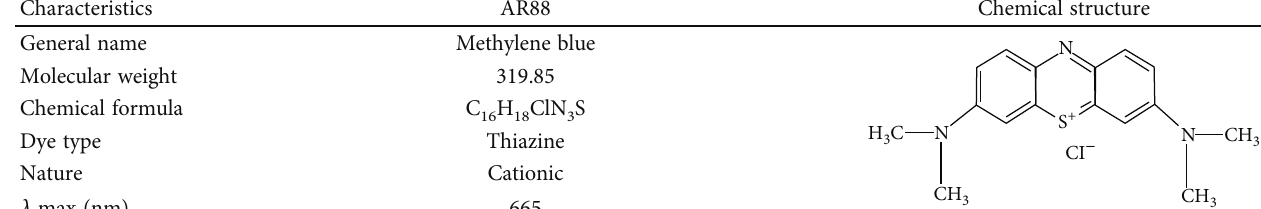
Table 1: General characteristics of MB.